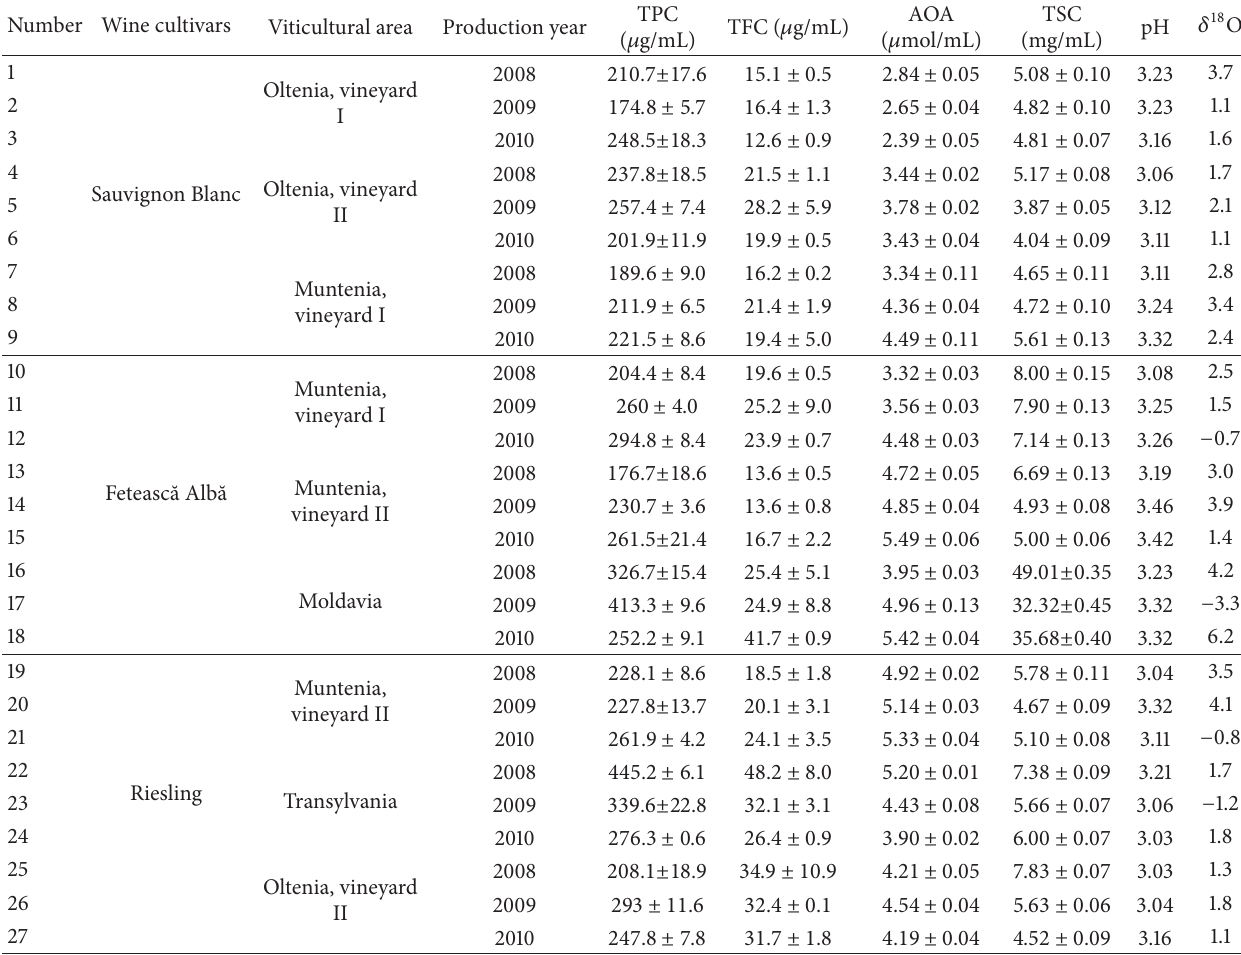
Table 1: The experimental values of determined parameters of investigated white wines. Number Wine